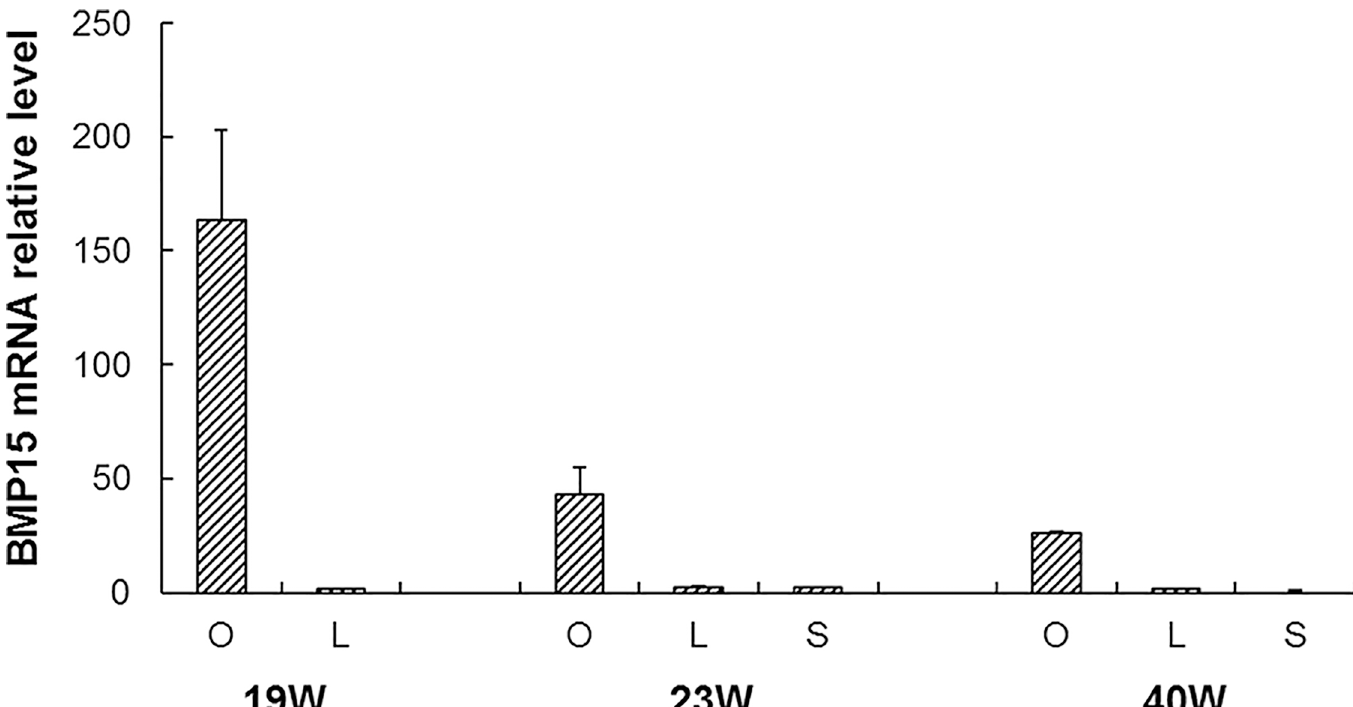
Fig 2. The expression of a chicken BMP15 gene in liver, ovary and oviduct at the age of the same